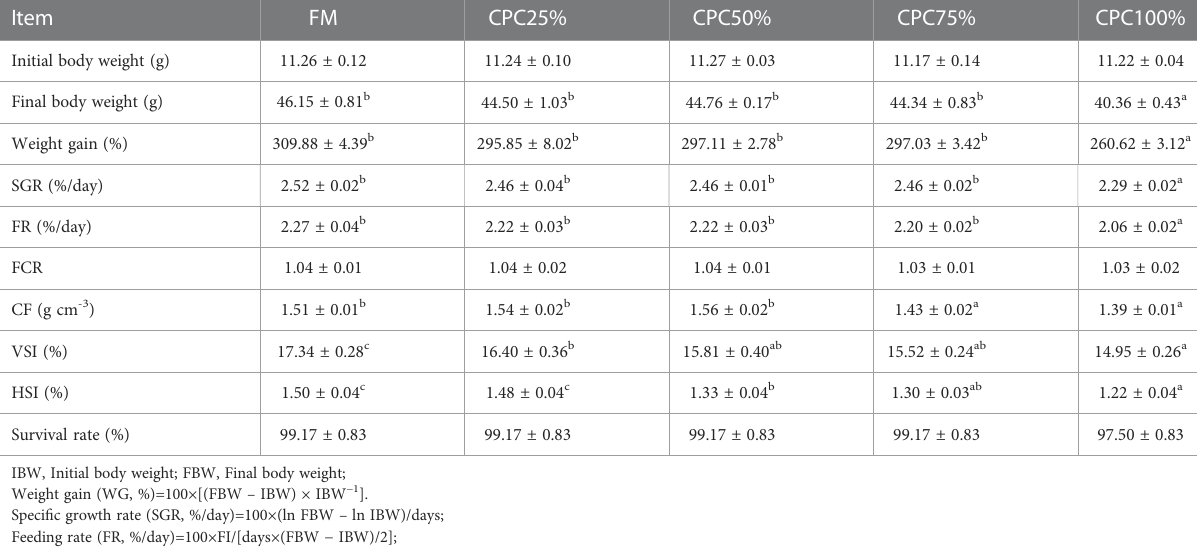
TABLE 4 Growth, feed utilization and survival of rainbow trout fed diets containing graded CPC (mean ± S.E.). Item FM